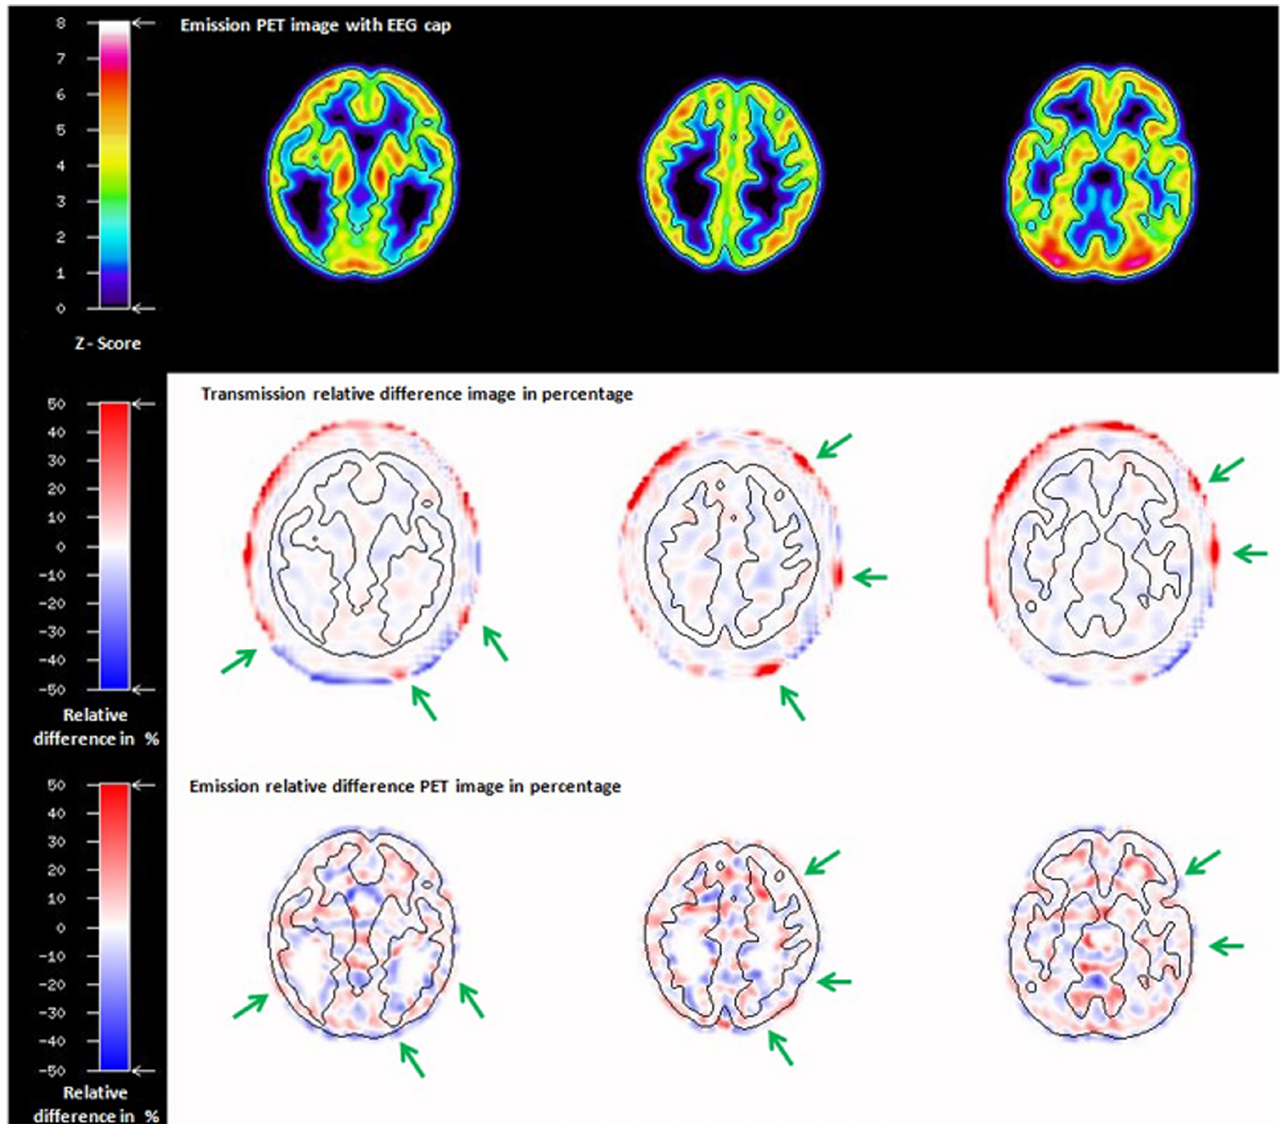
Fig 5. Axial slices at three different axial positions of the emission image of the Iida phantom with EEG cap (upper row), corresponding axial slices of the relative difference images from Fig 3 (transmission image, middle row), and from Fig 4 (emission image, bottom row). The green arrows indicate the positionof electrodes in transmissionand emission relative difference images in percentage. For visualisationof the position of the ‘brain’ regionof the Iida phantomin relationto the electrodes, a black contour corresponding to the outer contour of the emissionimage is shown on the difference